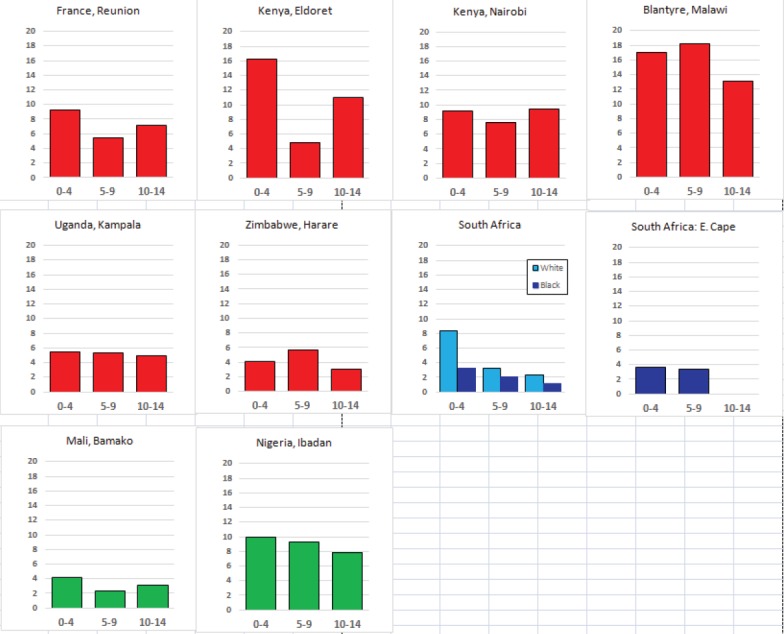
Age-specific histograms—rhabdomyosarcoma.